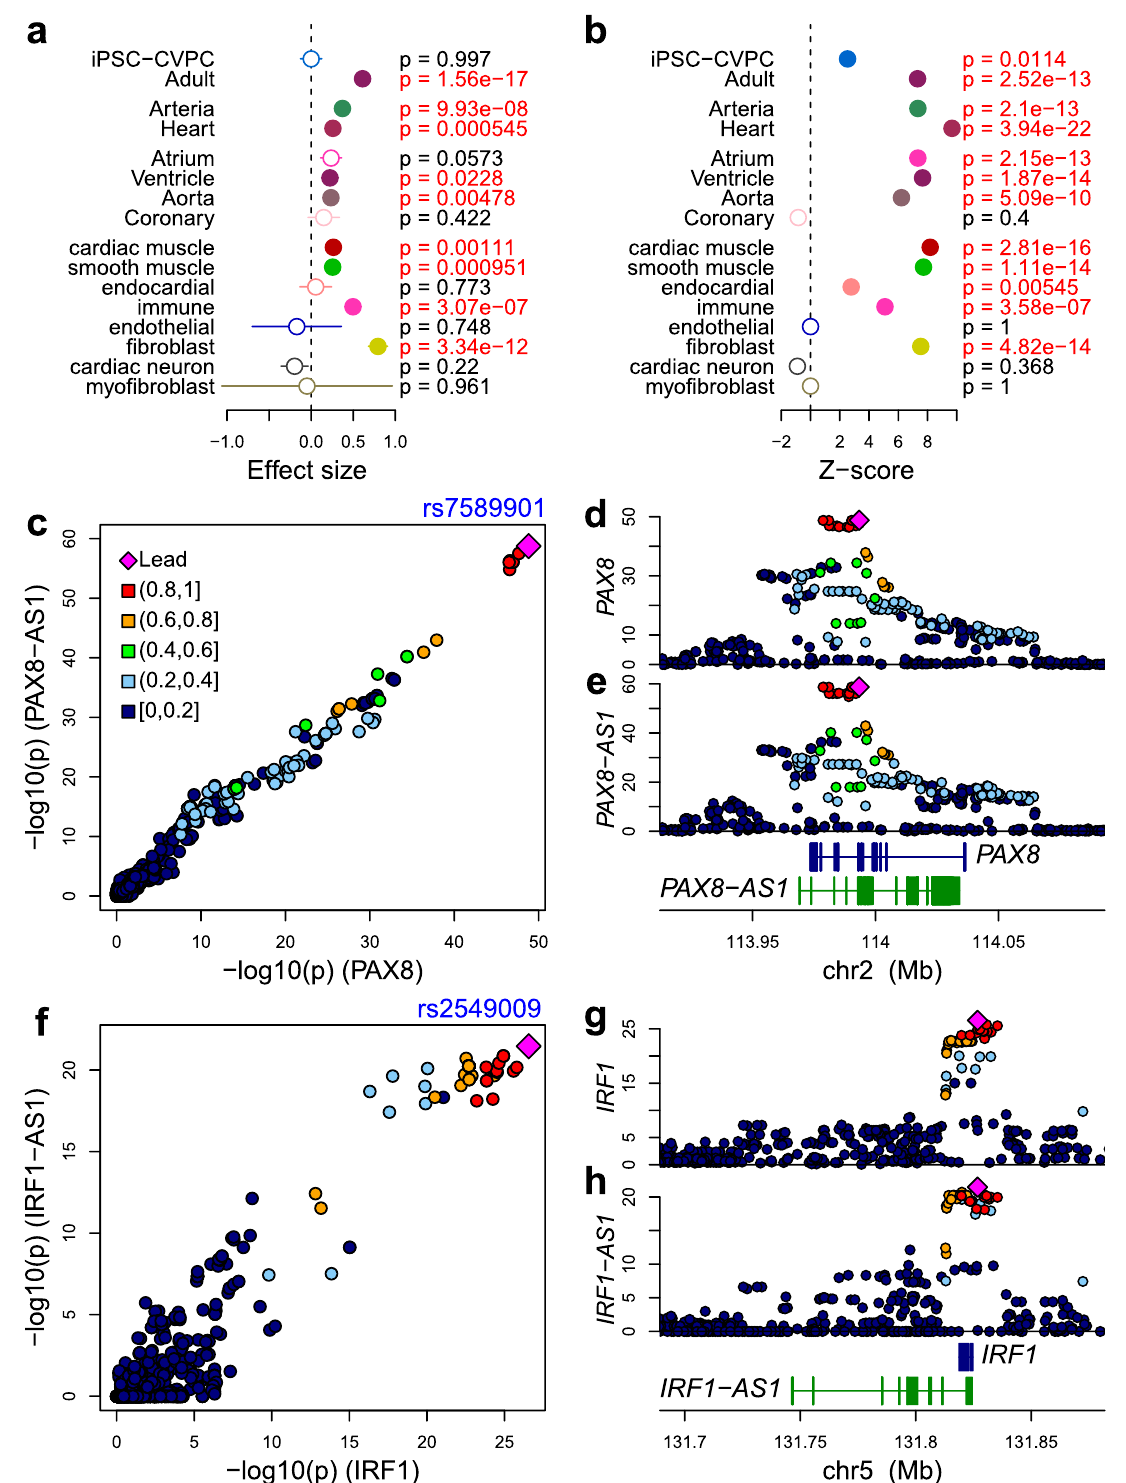
Fig.3|eQTLsignalsassociatedwithmultiplegenes.a EnrichmentofeGenesthat share the same eQTL signal with other eGenes or eIsoforms for having stage-, organ-, tissue- and cell type- eQTLs measured by linear regression analysis ( n =2778). Dots represent effect size and segments represent standard errors. Effectsizes,standarderrorsand p -valuesweremeasuredusingthe lm functioninR. b eGenes that share the same eQTL signals are enriched for being associated with